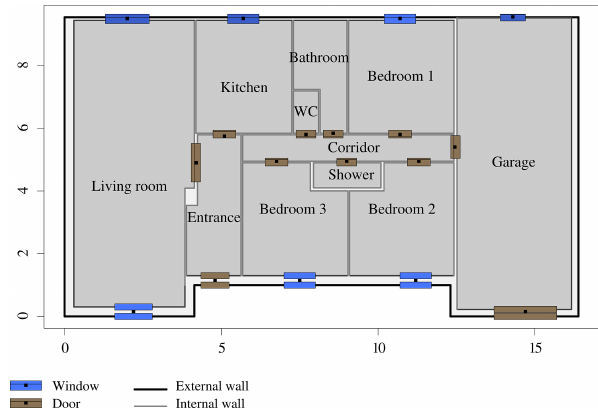
Figure 1. Top view of the single-storey house. The external walls are in black, the internal walls in grey, the doors in brown, and the windows in blue.